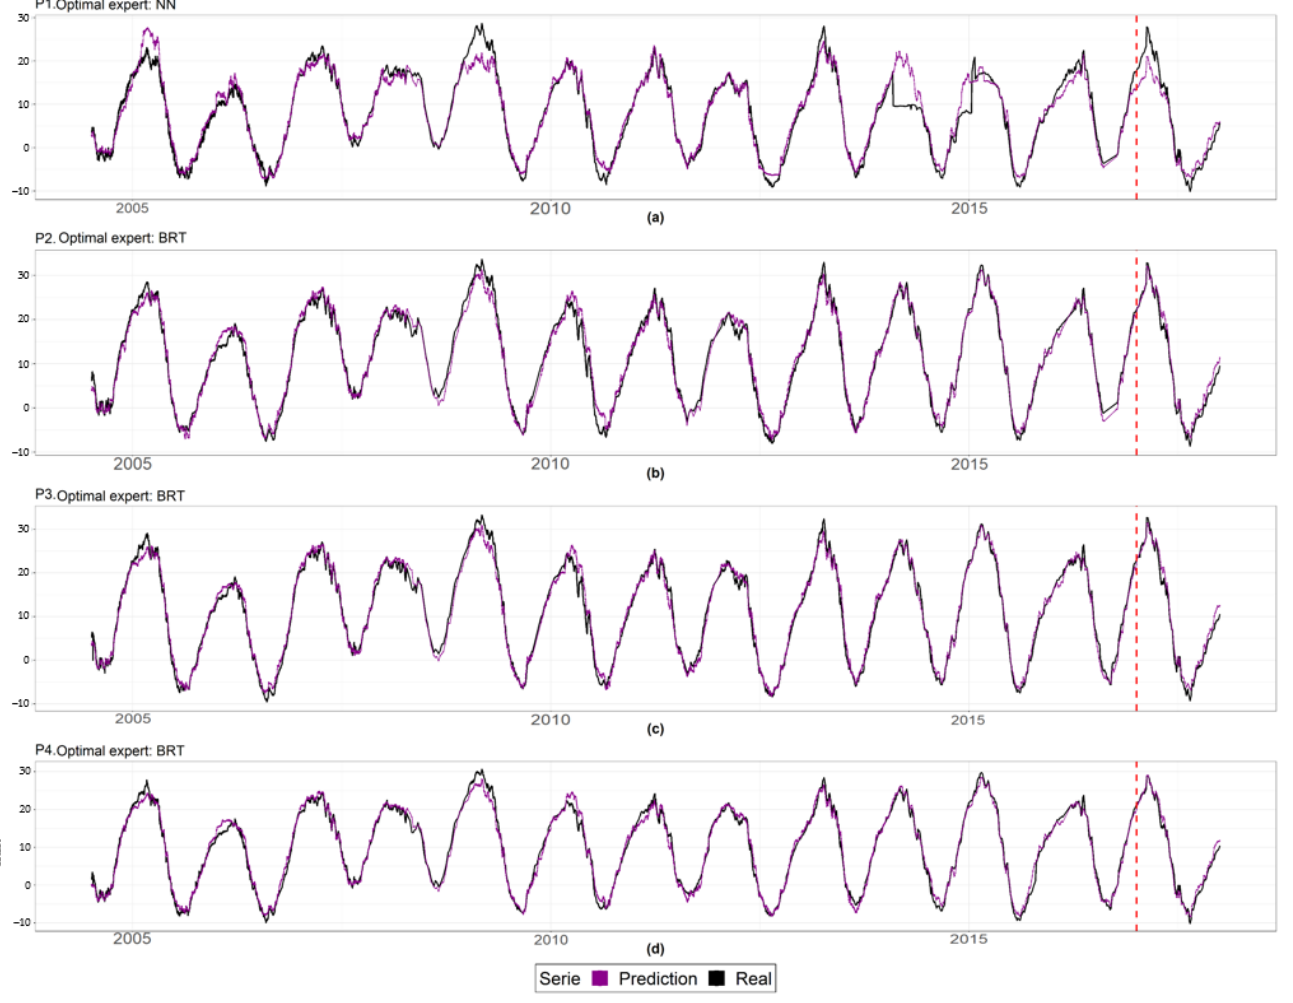
Figure 10. Series of predictions (magenta color) vs. series of measured values (black color) for each target. The red dashed line separates the training ( left ) and validation ( right ) periods. ( a ) Series of predictions of pendulum 1; ( b ) Series of predictions of pendulum 2; ( c ) Series of predictions of pendulum 3; ( d ) Series of predictions of pendulum 4. Table 3. Optimal hyperparameters of BRT found by Random and Blocked CV. NTree is the number of trees, nMinObsInNode is the minimum number of observations to consider in one node, shrinkage controls, overfitting and interaction depth control the tree depth.